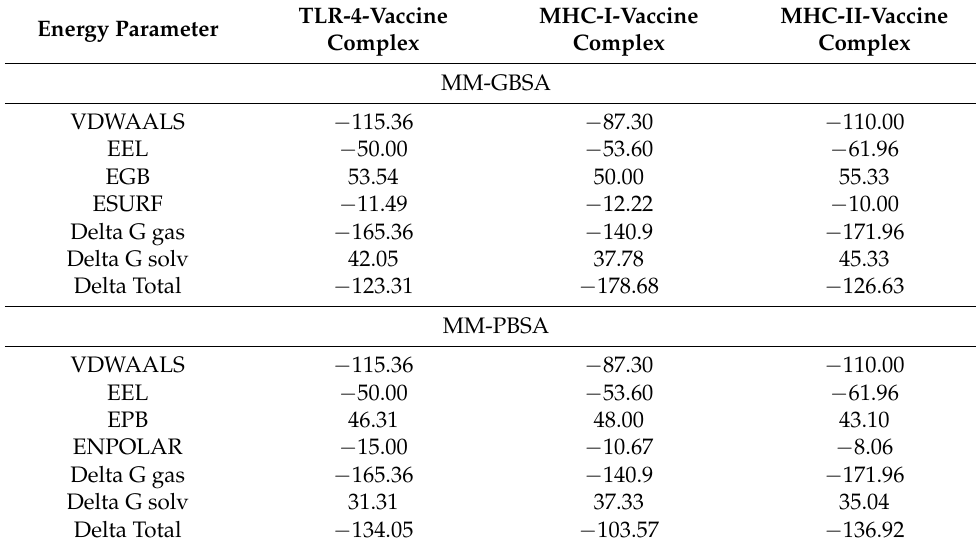
Table 10. Different binding free energies between vaccine and receptors. All values are given in kcal/mol. TLR-4-Vaccine MHC-I-Vaccine Energy Parameter Complex Complex